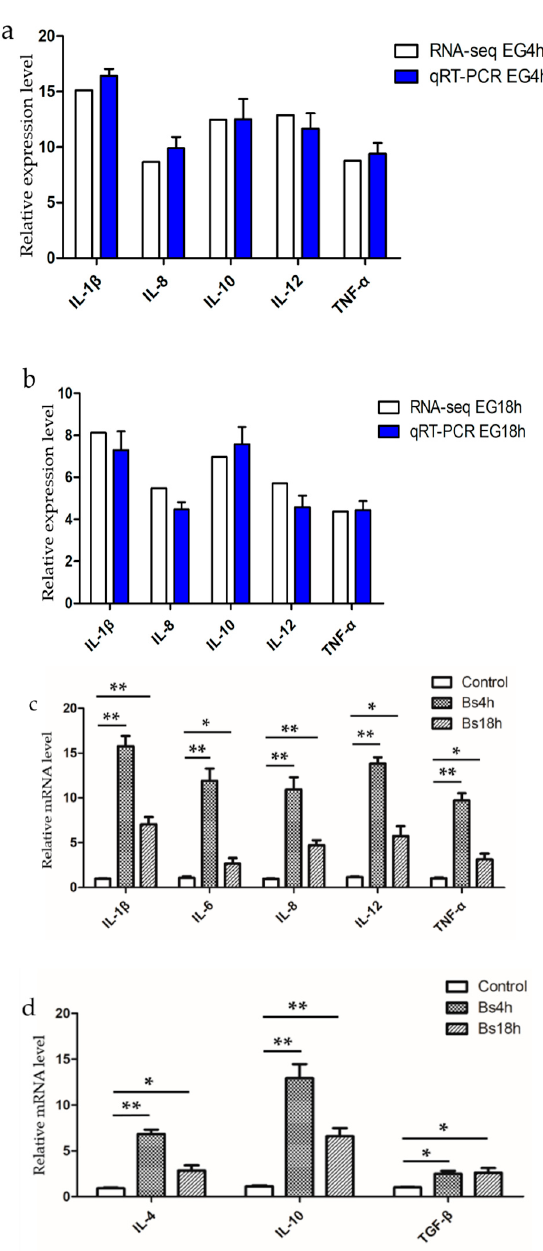
Figure 7. Validation of RNA-seq data by qPCR and the mRNA expression level of immune-related cytokines after Bacillus subtilis stimulation. ( a ) The results of qPCR validation of EG4h, compared with the RNA-seq data of EG4h. The expression levels of five genes were detected by qRT-PCR (blue column) and compared with the results of RNA-seq (white column). ( b ) The results of qPCR validation of EG18h, compared with the RNA-seq data of EG18h. The expression levels of five genes were detected by qRT-PCR (blue column) and compared with the results of RNA-seq (white column). ( c ) The expression of five pro-inflammatory cytokine genes ( IL-1 β , IL-6 , IL-8 , IL-12 , and TNF- α ) increased during the stimulation. ( d ) Three anti-inflammatory cytokine genes ( IL-4 , IL-10 , and transforming growth factor ( TGF)- β ) increased at both time point. All the three independent experiments had the same trend on cytokines by qRT-PCR. Data are expressed as mean ± SD ( n = 3). * p < 0.05, ** p < 0.01 compared with the control group.